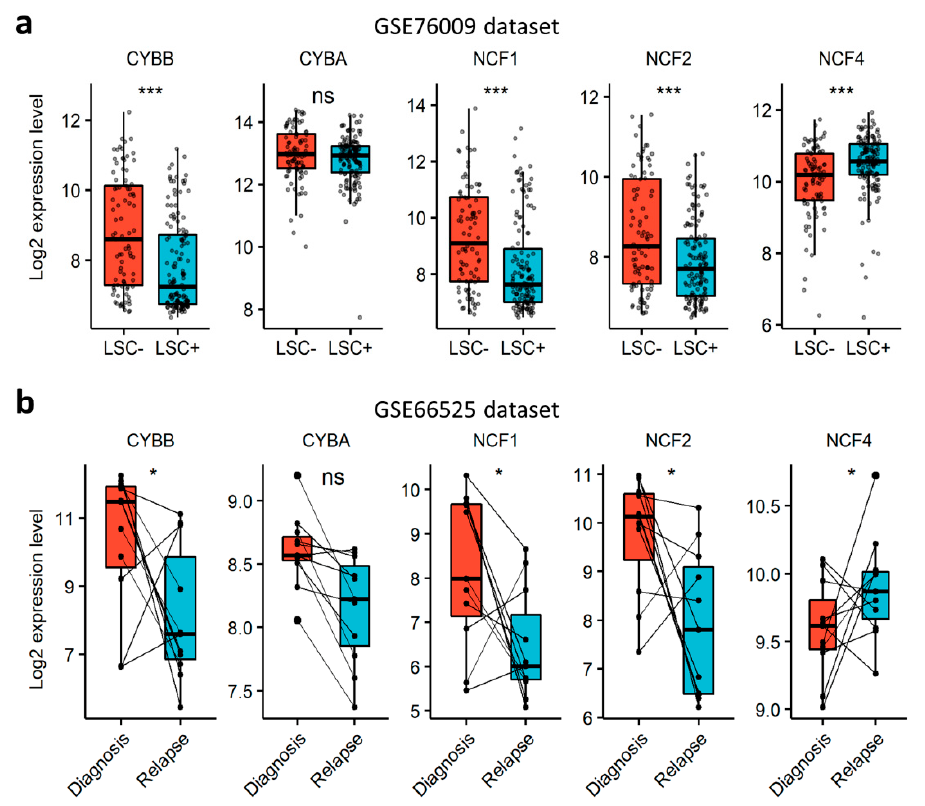
Figure 4. Expression profile of genes coding for NOX2 subunits, according to AML stemness and resistance to therapy. ( a ) The expression profile of genes coding for NOX2 subunits in an AML-engrafting leukemic stem cell enriched (LSC + ) population compared to a non-engrafting LSC depleted (LSC − ) population from the GSE76009 dataset [33]. Student’s t -test, followed by BH-adjustment, was used for the pairwise comparisons between the LSC + and LSC − groups. ( b ) The expression profile of genes coding for NOX2 subunits in AML patients at relapse compared to diagnosis from the GSE66525 dataset [32]. Wilcoxon’s signed-rank test was used for the pairwise comparisons between relapse and diagnosis. ns: not significant, *: p < 0.05; ***: p < 0.001.